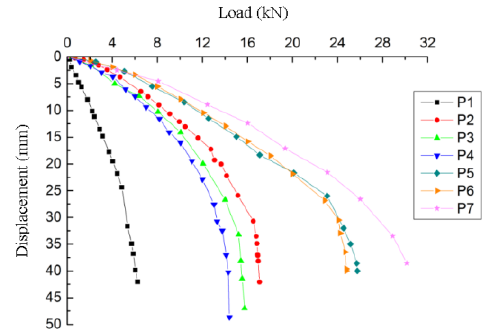
Figure 8. Load-displacement curve of seven kinds of pile under vertical load.